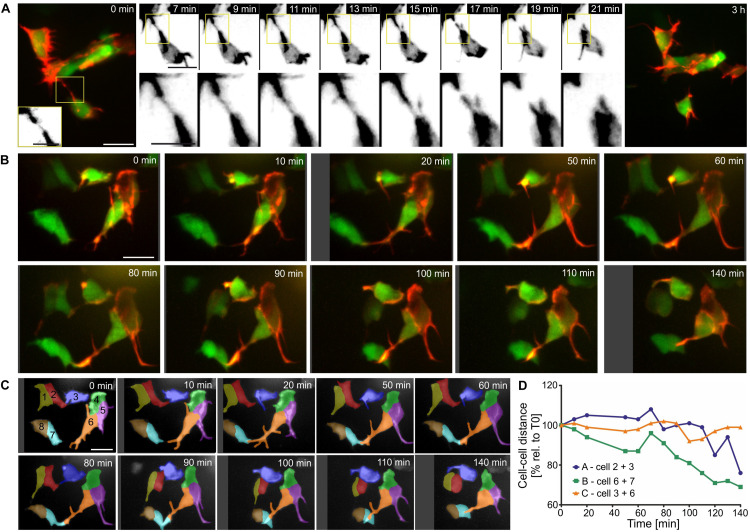
Filopodia form both transient and stable connections. Z-projections of confocal time-lapse series of Tam treated triple Tg(pax6b:GFP;nd:Gal4ER; UAS:LifeActTdT) larvae (for details see Supplementary Table S2). (A,B) LifeActTdT actin labeling is shown in red or gray, combined with pax6b:GFP (green, far left and far right panels in A). (A) Example of a transient connection between nearby cells. (B) Movements of loosely clustered cells correlate with formation of cell-cell connections. (C) Time series shown in (B), with cells segmented and labeled by number and pseudocoloring to facilitate identification in subsequent images and analysis of cell movements. (D) Quantification of the center-to-center distance of cells over time show that cells which connected through protrusions (line ‘A’ - cells 2 + 3, line ‘B’ - cells 6 + 7) move closer together, compared to cells that were not attached to each other (line ‘C’ – cells 3 + 6). Scale bars, 10 μm.